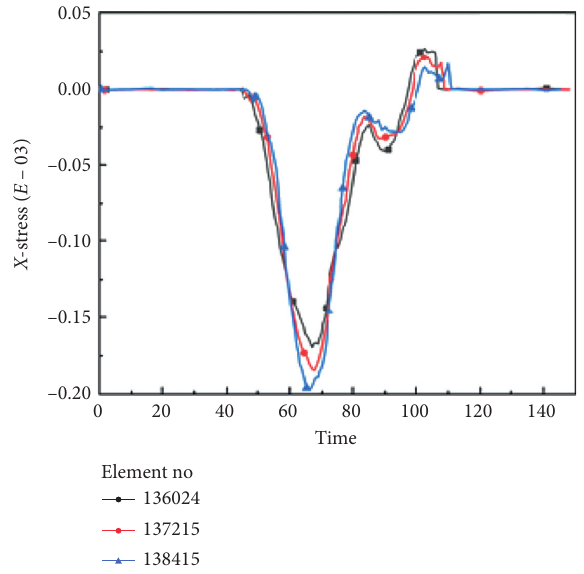
Figure 17: Curve of X -stress on selected